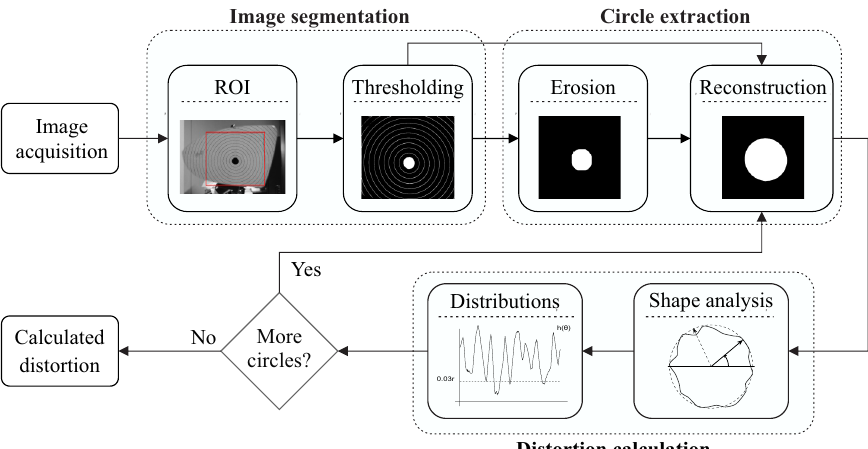
Figure 3. Block diagram of the proposed DCMIP.